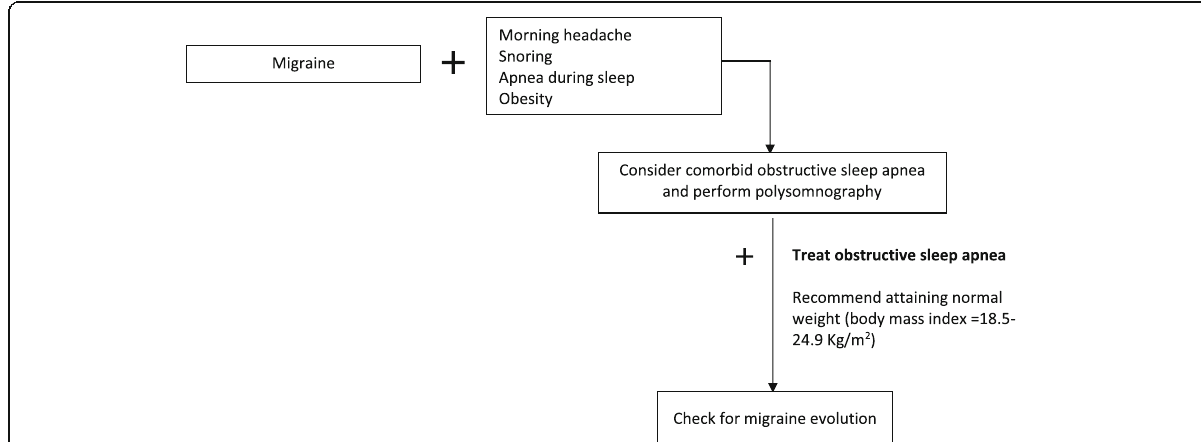
Fig. 3 Interaction between migraine and obstructive sleep apnea. Although available studies failed to find a causal relationship between obstructive sleep apnea (OSA) and migraine, little evidence suggests that OSA may be a trigger of migraine in selected patients and facilitate migraine progression. For this reason it would be reasonable check for the presence of signs or symptoms attributable to OSA in migraine patients, especially in those reporting morning headache, habitual snoring, apnea episodes during sleep, obesity, craniofacial morphology and oral anatomy, neuromuscular disorders, and substances use. Clinicians should screen and select patients to be studied with polysomnography upon suspicion of sleep-related breathing disorder. Patients with OSA diagnosis should receive the guideline recommended treatments. Since available evidence suggests that obesity is a major risk factor for OSA development and progression and for migraine chronification, appraisal of a normal weight (body mass index=18.5-24.9 Kg/m 2 ) should be strongly encouraged in patients with comorbid OSA and migraine since an improvement of both OSA severity and migraine frequency might be